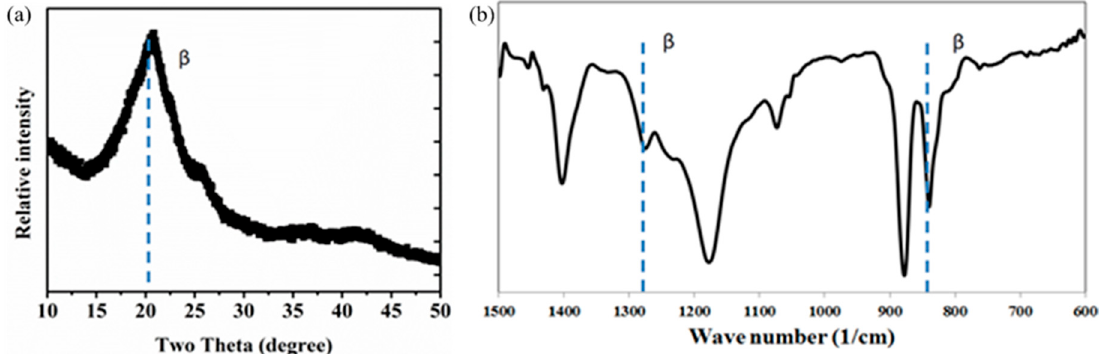
Figure 2. ( a ) XRD and ( b ) FTIR patterns are collected for PVDF nanofibers with a diameter of 800 nm.